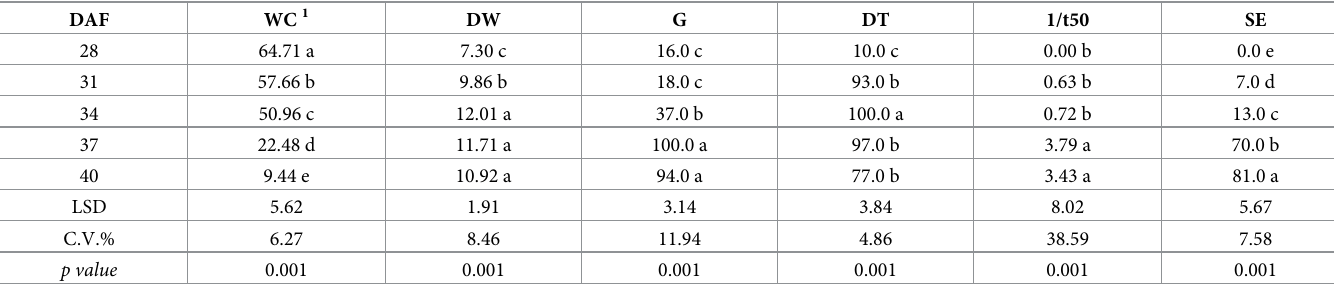
Table 1. Statistical analysis. Information of the data evaluated in cowpea seeds ( Vigna unguiculata L., Walp) during maturation stages (28 to 40 DAA) � . DAF